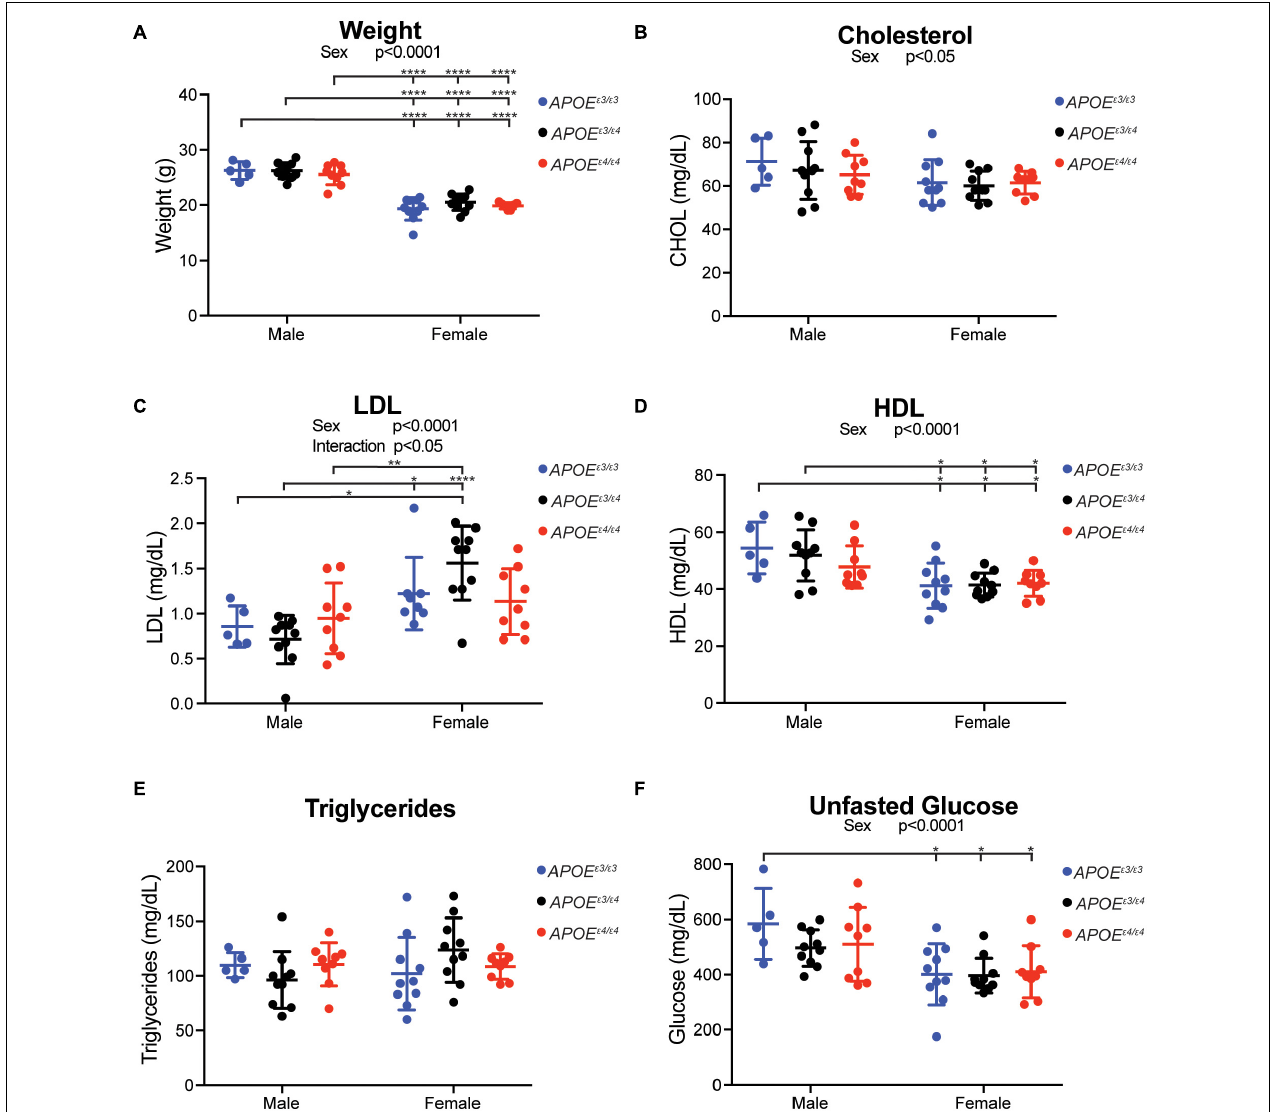
FIGURE 2 | Plasma cholesterol composition affected by sex, but not APOE genotype, at 2 months. (A) Weight (grams, g) at harvest in both male and female APOE mice showed expected significant sex differences across all genotypes. (B) Total plasma cholesterol concentration revealed a significant effect of sex. (C) Low density lipoprotein (LDL) concentration showed a significant interactive effect between APOE genotype and sex, as well as a main effect of sex. (D) High density lipoprotein concentration (HDL) showed a significant effect of sex. (E) Triglyceride concentration showed no effect by APOE genotype or sex. (F) Unfasted glucose showed a significant sex effect. Significant ANOVA results are stated under the title of the graph, significant Tukey post hoc results are shown on graph between significant groups. All significance data can be found in Supplementary Table 1